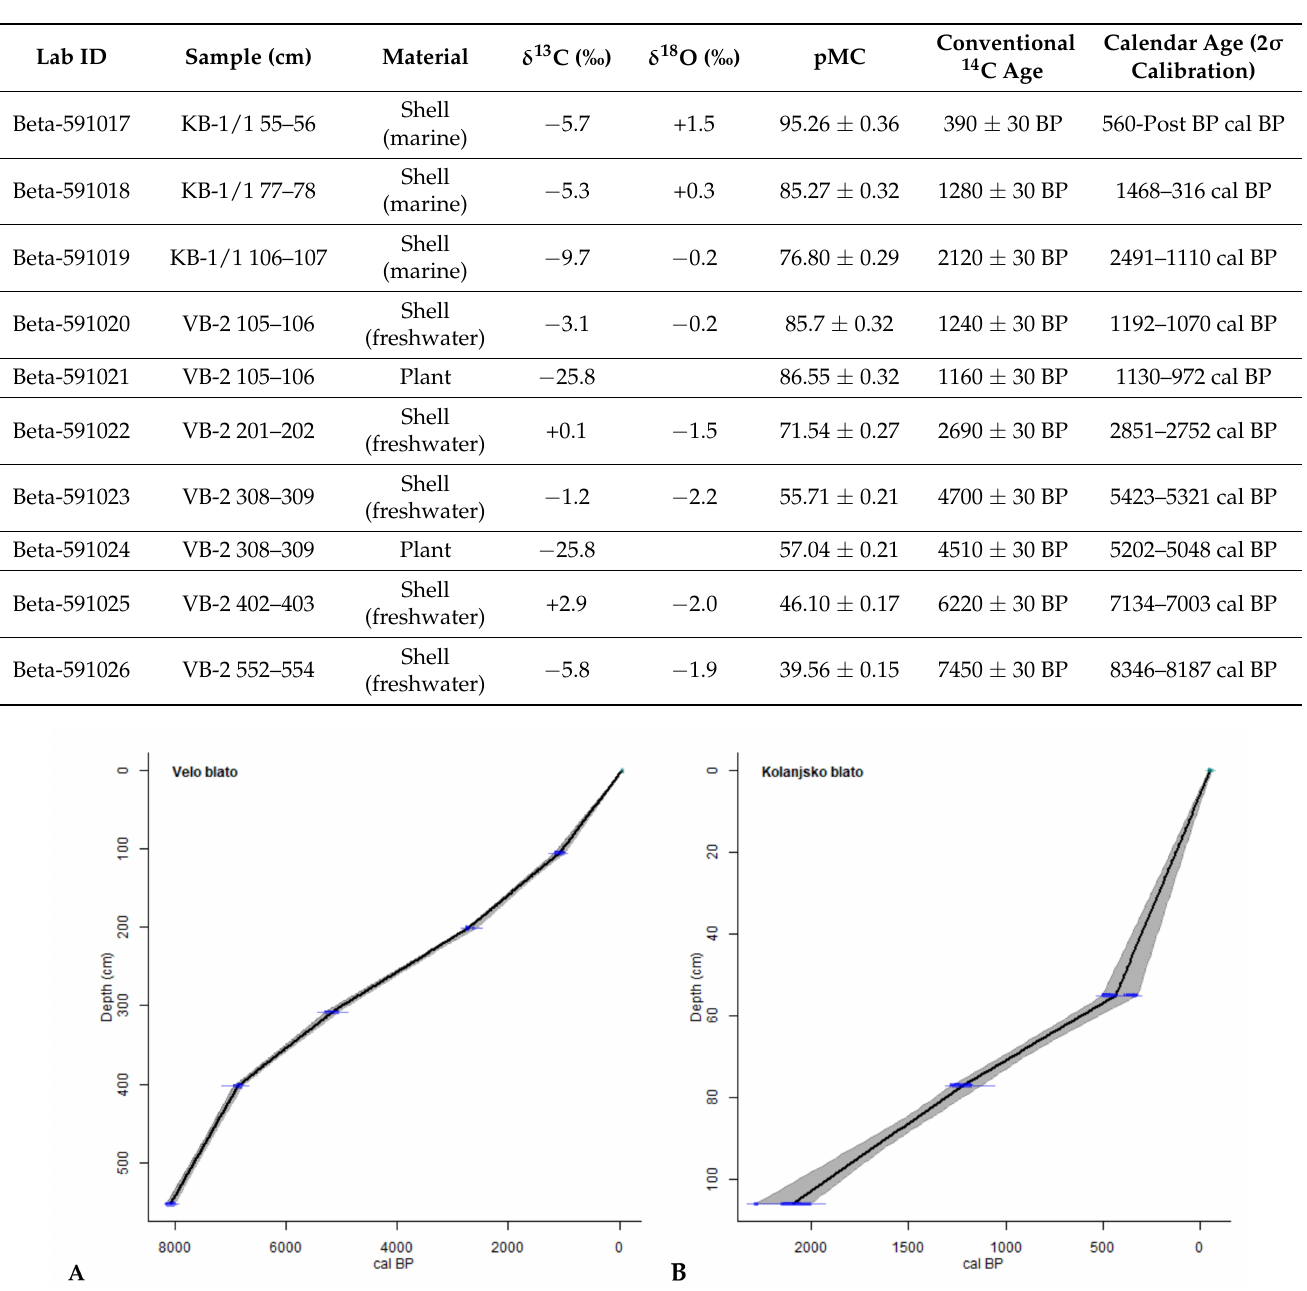
Table 2. Radiocarbon dates obtained in the Velo (VB-2) and Kolanjsko Blato (KB-1/1) sediment cores.